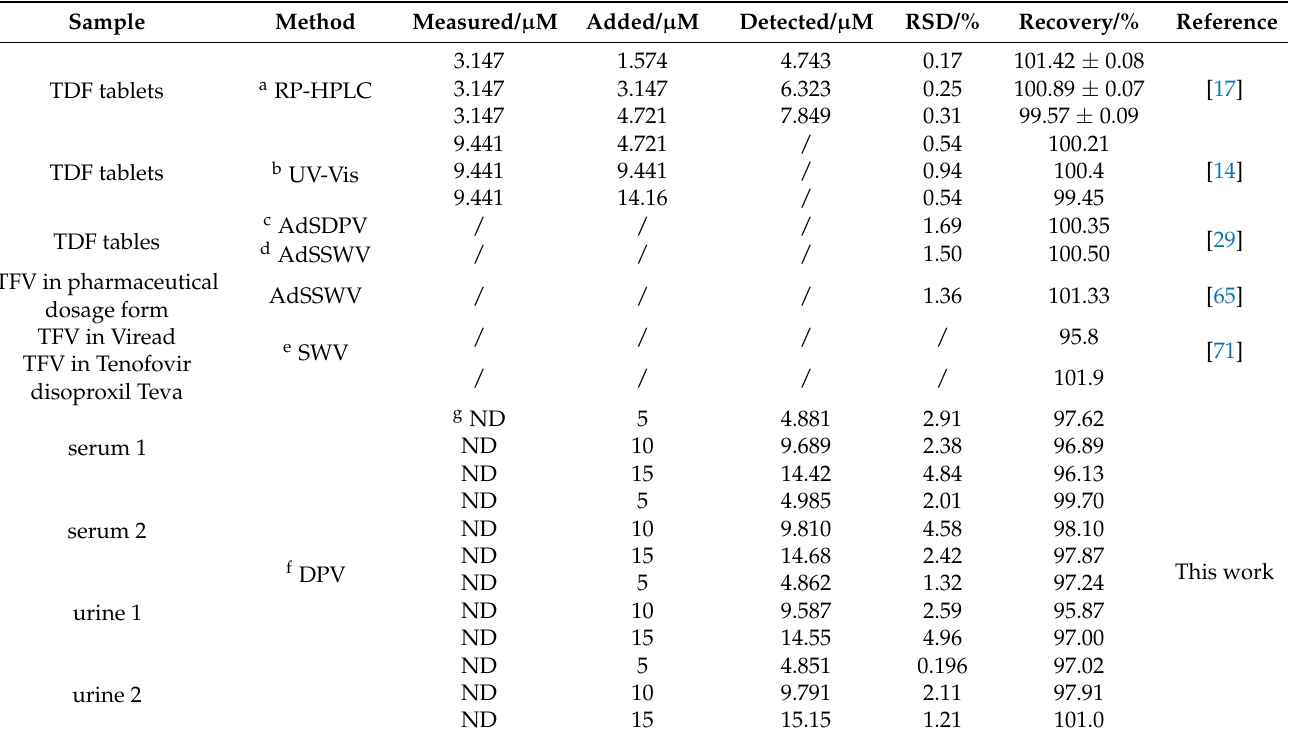
Table 2. Recovery of TDF in actual